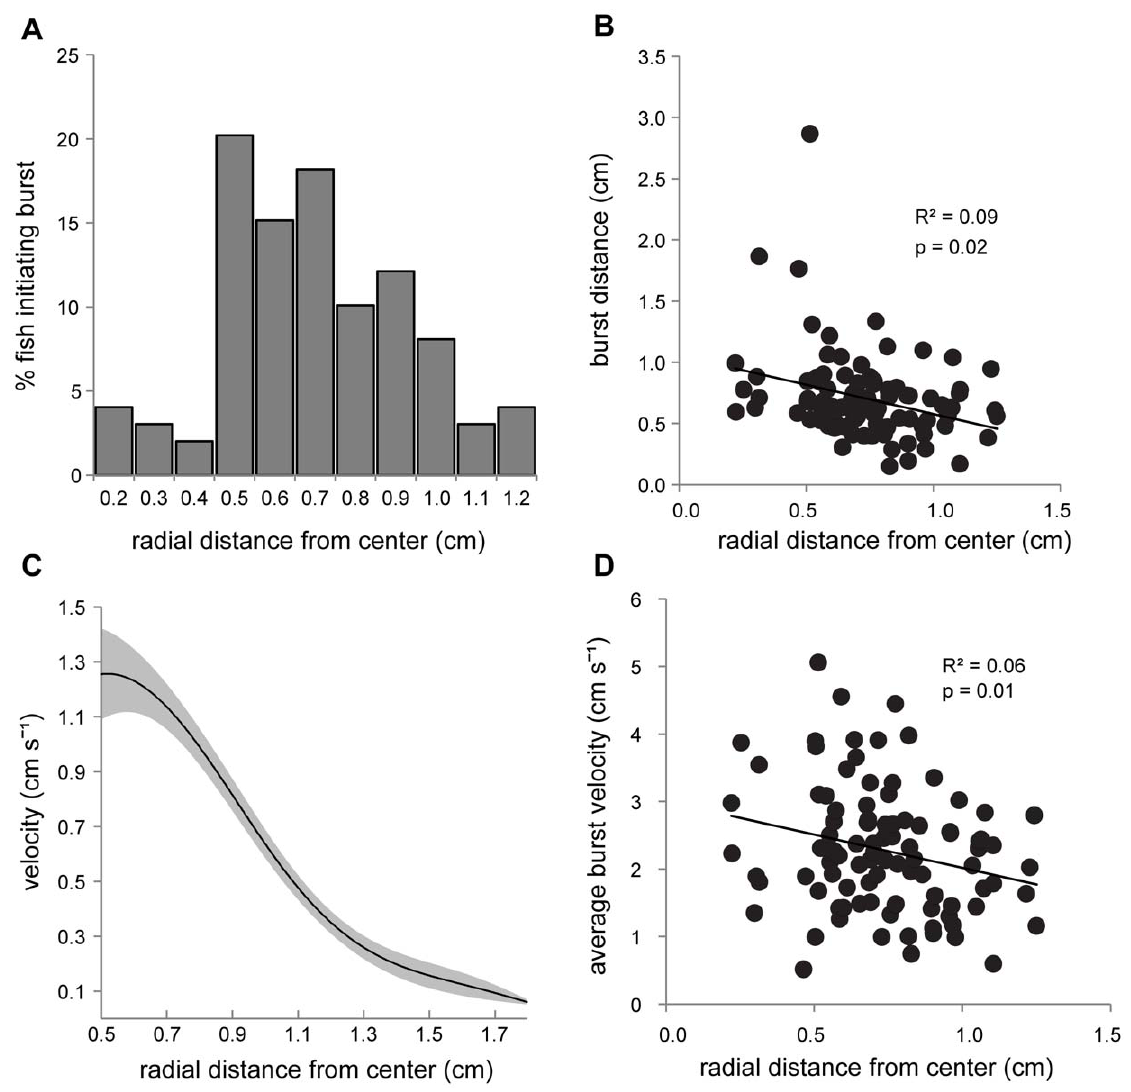
Figure 3. Characteristics of bursting behavior in the suction chamber for untreated larvae. A. Percentage of fish initiating a burst at a given radial distance from the suction source, where the origin of the suction source is at 0 cm. Most larvae initiate a swimming burst between 0.5– 1.0 cm (1–2 body lengths) away from the suction source, while far fewer larvae initiate a burst closer or further away (N=98). B. Relationship between burst distance and location of burst initiation. The closer to the suction source a burst is initiated the farther the distance traveled during the burst (N=98, R 2 =0.09, p=0.02). C. Velocity of passively drifting euthanized larvae as a function of distance from the suction source. The average drifting velocity of ten bodies was smoothed using a cubic spine (gray shaded area represents the standard error of the mean, N=10). D. Average burst velocity as a function of the location of burst initiation. The closer to the suction source the burst is initiated, the faster the burst velocity (N=98, R 2 =0.06, p=0.01).